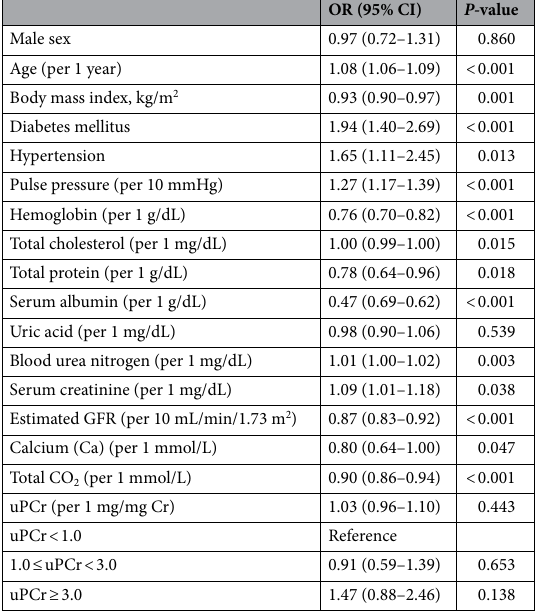
Table 2. Associated factors of sarcopenia. BP, blood pressure; CI, confidence interval; GFR, glomerular filtration rate; OR, odds ratio; uPCr, urine protein-creatinine ratio.